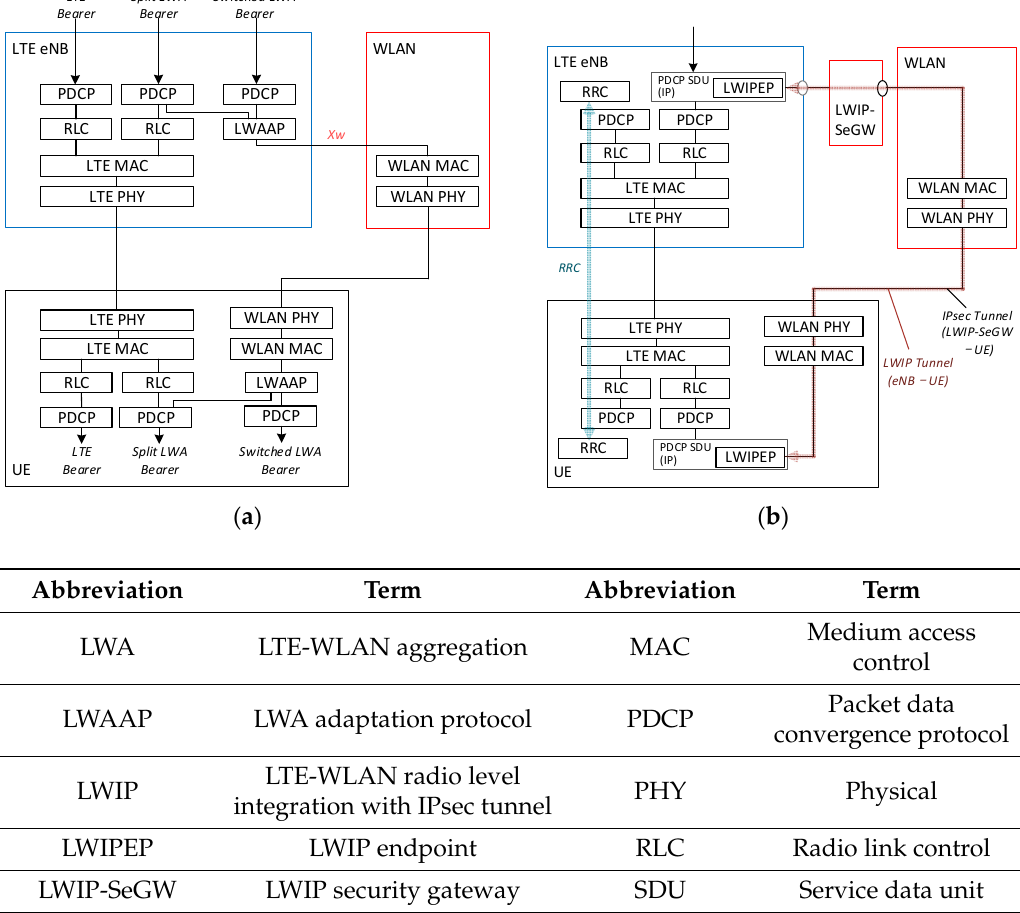
Figure 4. LTE-WLAN interworking architectures in Release 13: ( a ) LTE-WLAN aggregation (LWA) in a non-collocated scenario and ( b ) LTE-WLAN radio level integration with IPsec tunnel